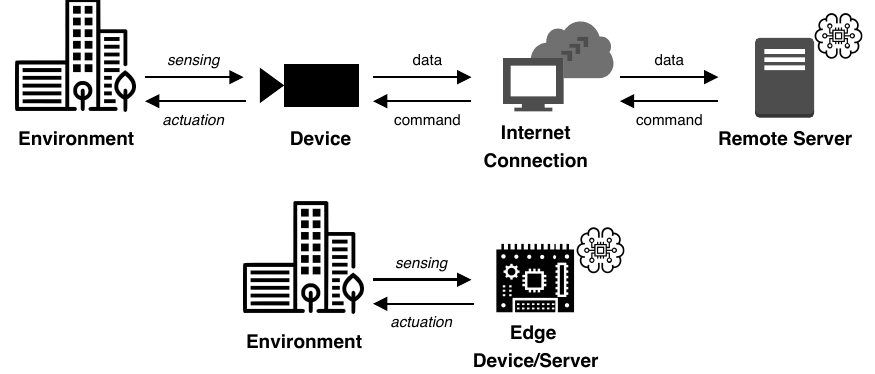
Figure 1. From remote (e.g., cloud-based) to local (e.g., EI) data